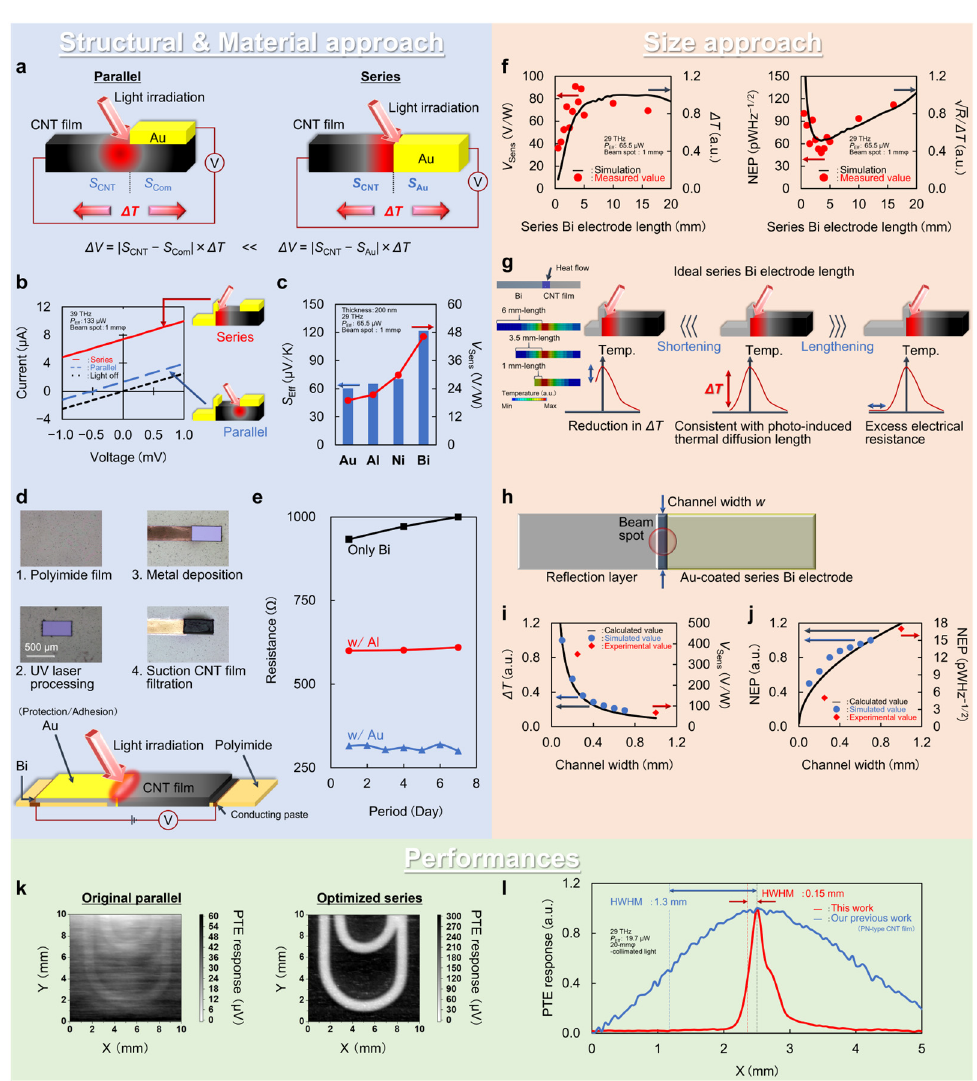
Figure 3. PTE effect in the CNT film channel–metal electrode boundary. ( a ) Operating mechanism. ( b ) Change in the device’s photo-current responses depends on the electrode structure. ( c ) Changes